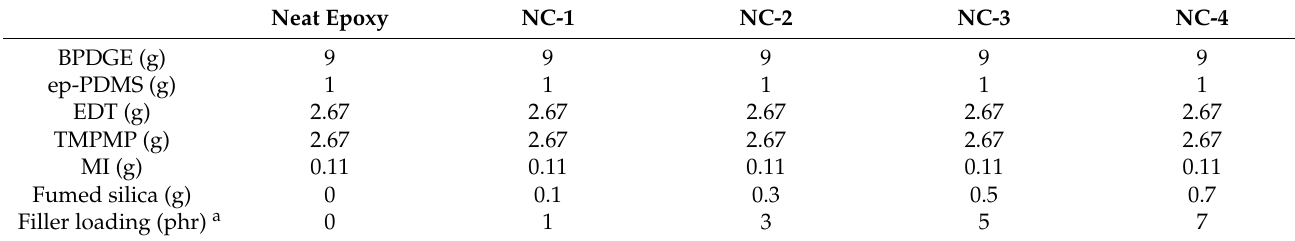
Table 3. The compositions of neat epoxy and